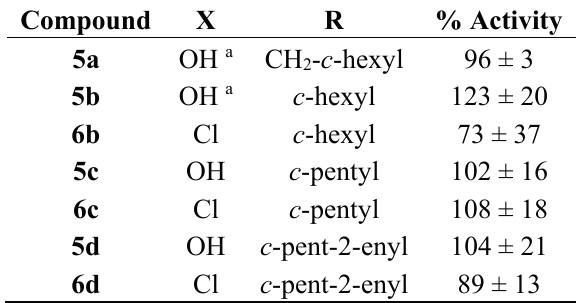
Table 4. % Activity of NTH1 in the presence of compounds 5 or 6 at 0.5 mM